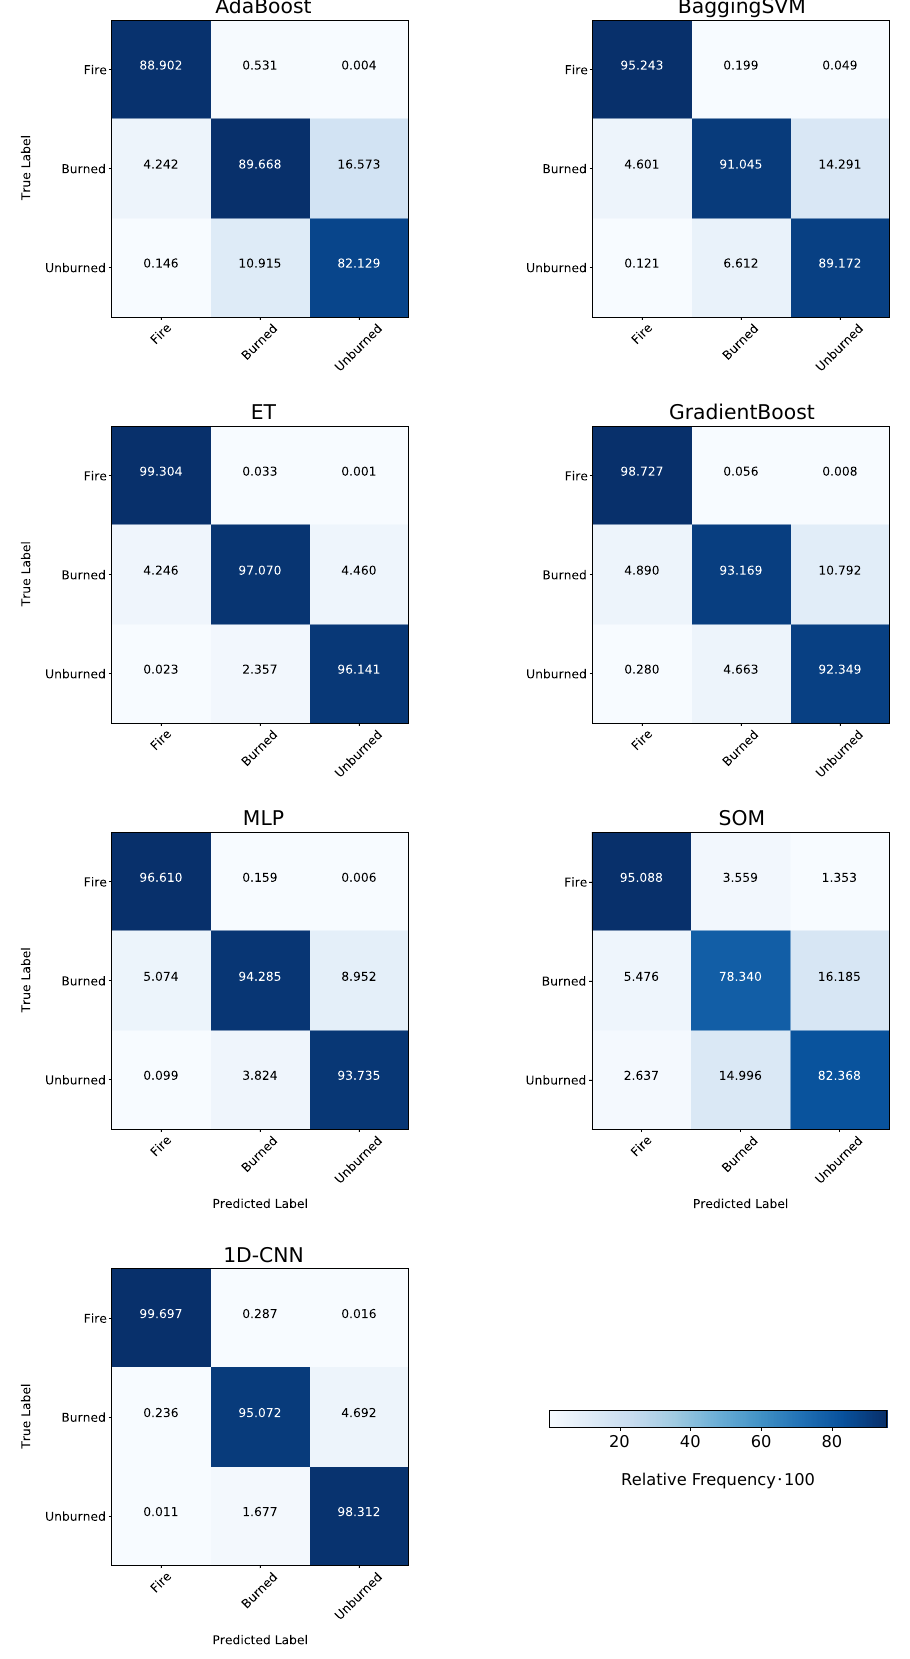
Figure 10. Normalized confusion matrices for the applied ML models. The prediction was performed on Subset 2 and compared to the reference data. The ML models were trained on Uset 3